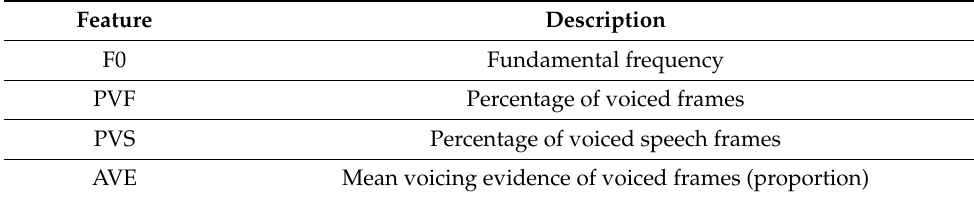
Table 2. Acoustic speech features captured in the